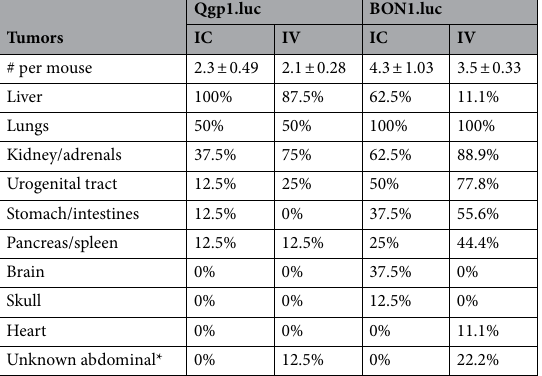
Table 1. Summary of BLI model findings. *Precise anatomic location inadvertently hindered during